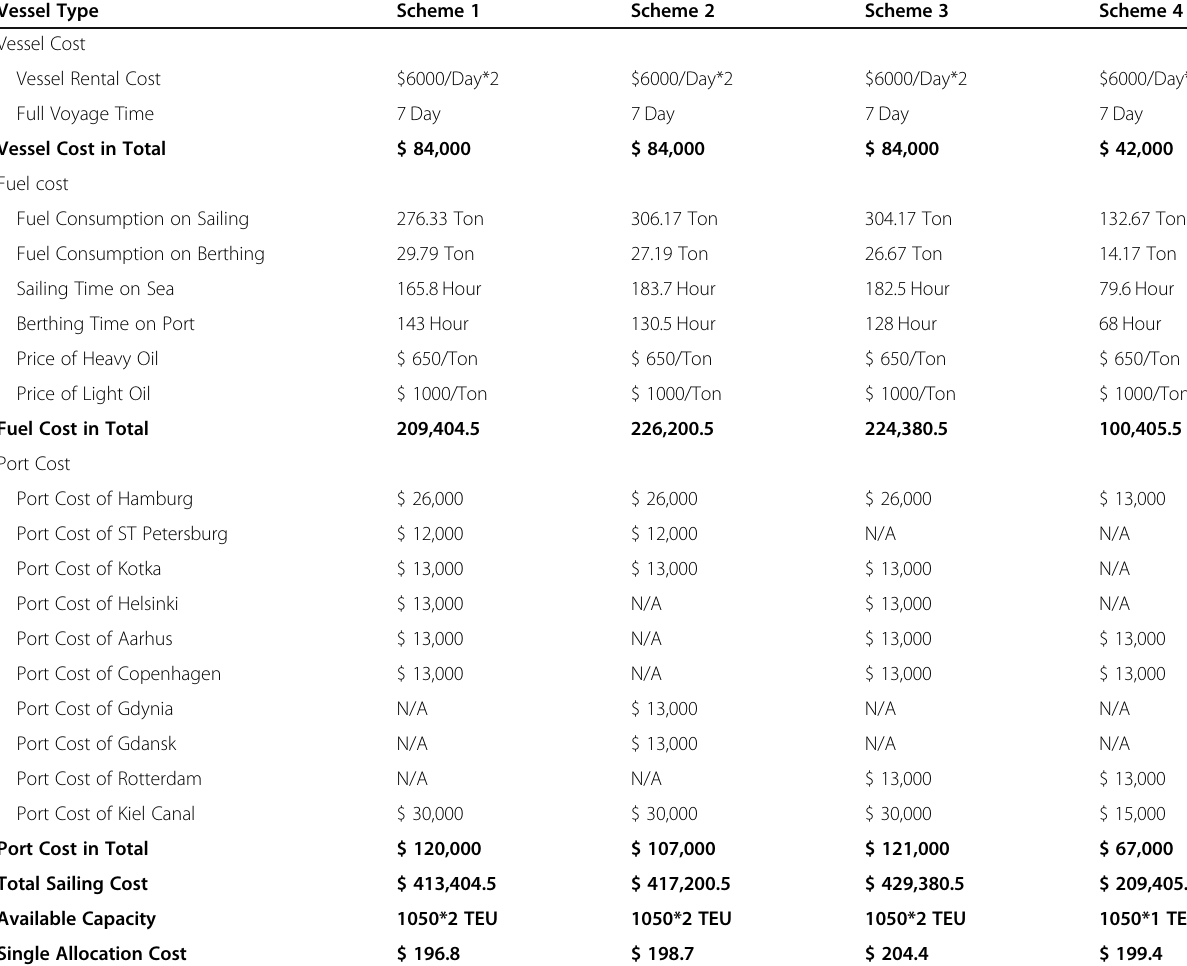
Table 8 Cost comparison between Four Alternatives of Feeder Network Design (Source: authors) Vessel